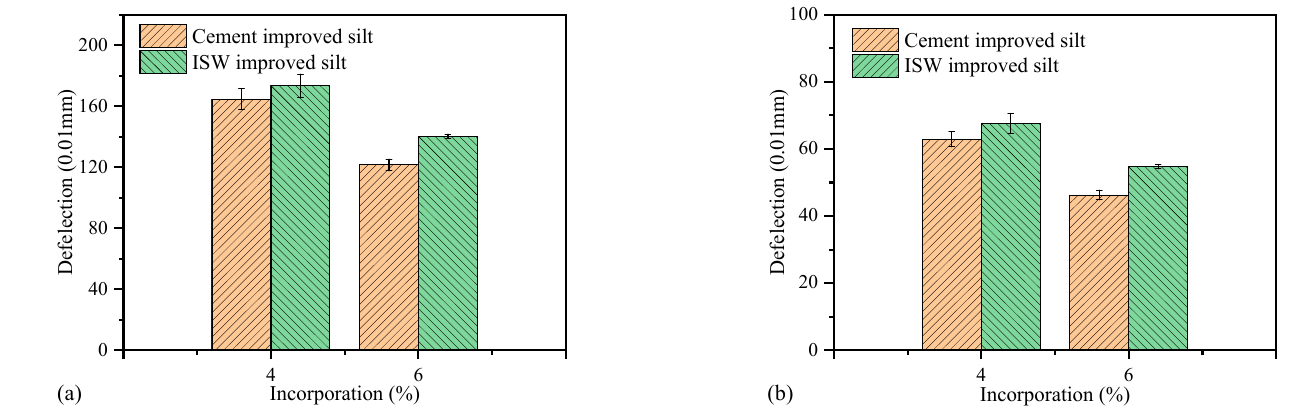
meet the requirements from the aspect of in-situ application.